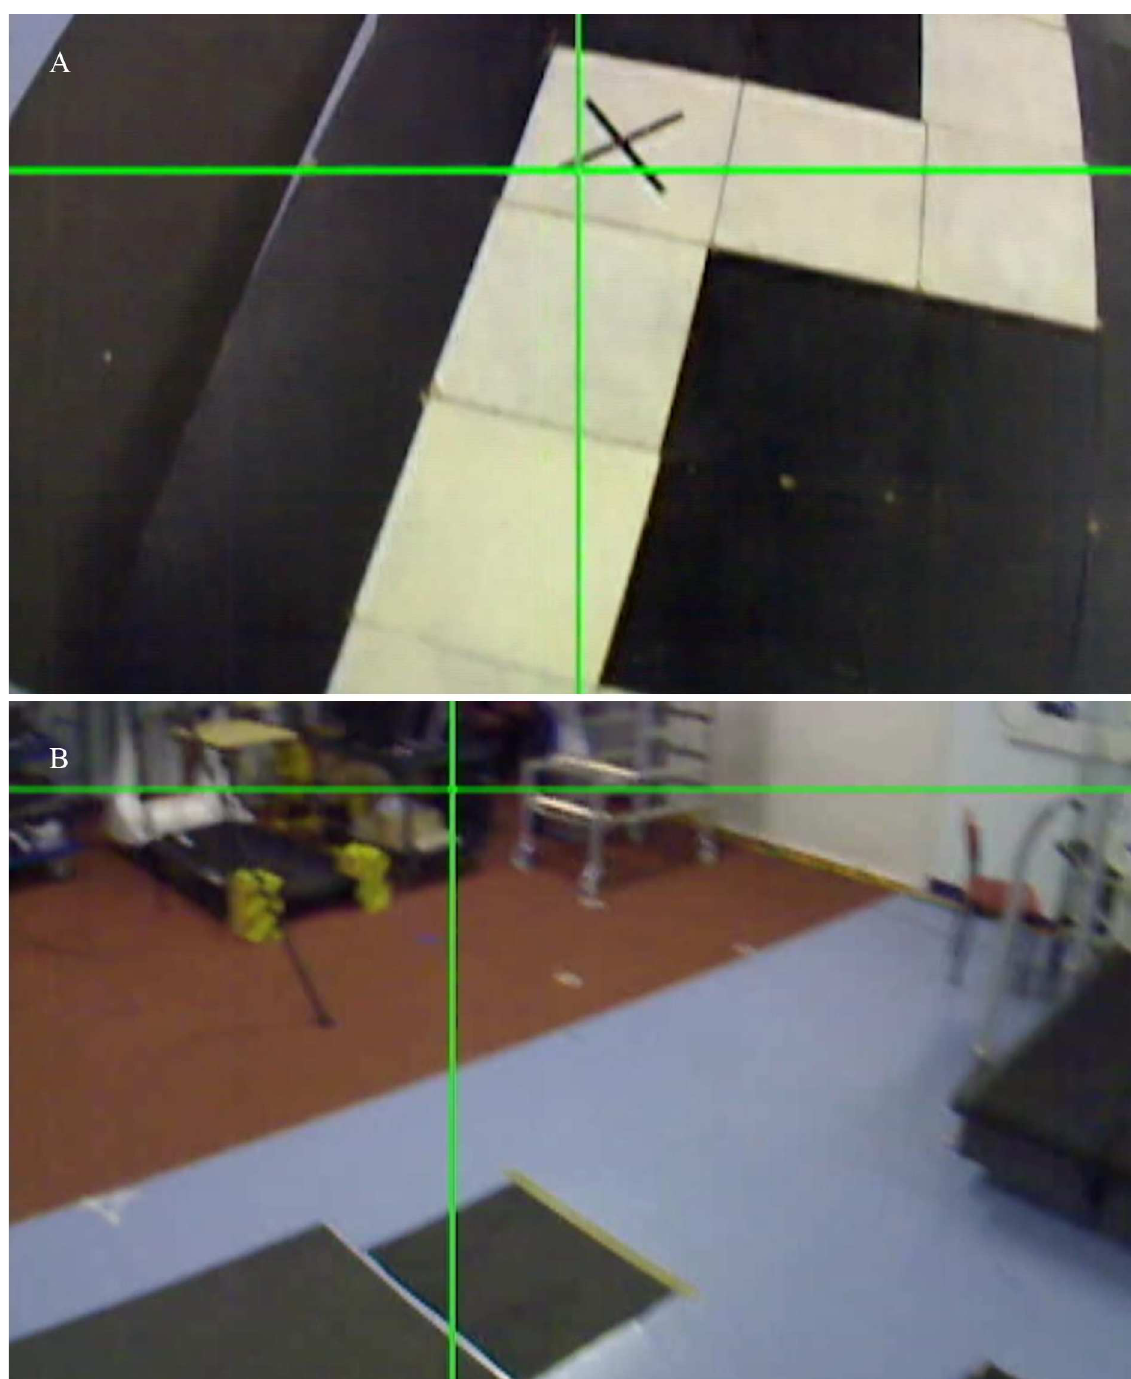
Fig 2. a. An example of a task-relevant ‘inside’fixation, whereby the participant fixates on an area within their walking path. b. An example of a task-irrelevant ‘outside’fixation, whereby the participant fixates on an area outside of their walking